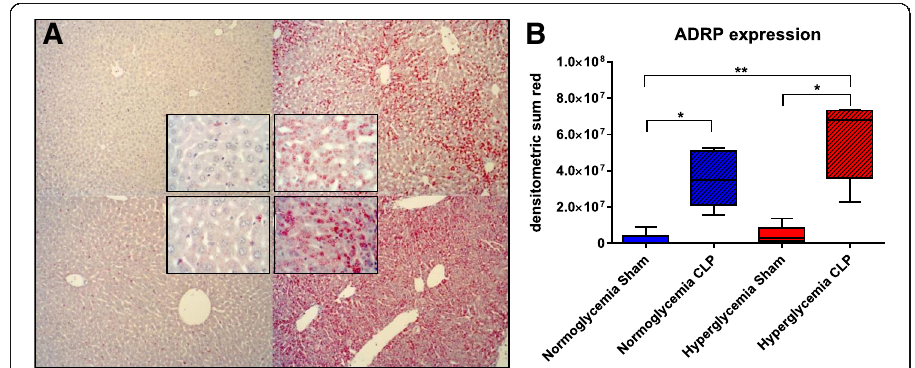
Fig. 4 Lipid droplet formation in the liver. a Exemplary pictures for ADRP immunohistochemistry (10×, insets 40×, top left normo sham, top right normo CLP, bottom left hyper sham, bottom right hyper CLP) b ADRP expression, * p ≤ 0.05, ** p ≤ 0.01. All data is presented as median (interquartile range). Kruskal-Wallis analysis of variance on ranks with post hoc Dunn ’ s test for multiple